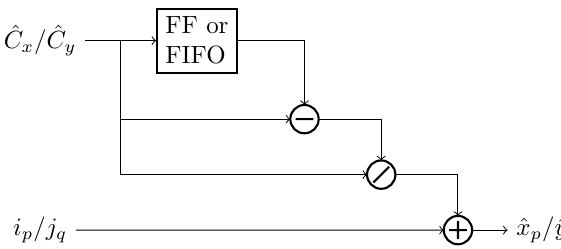
Figure 5. Diagram for the implementation sub-pixel interpolation in x and y